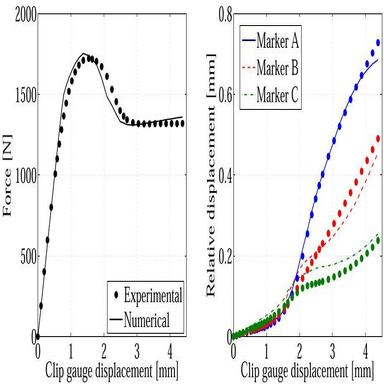
Mechanical response using VTM model for the best fitting of necking kinematic f d .